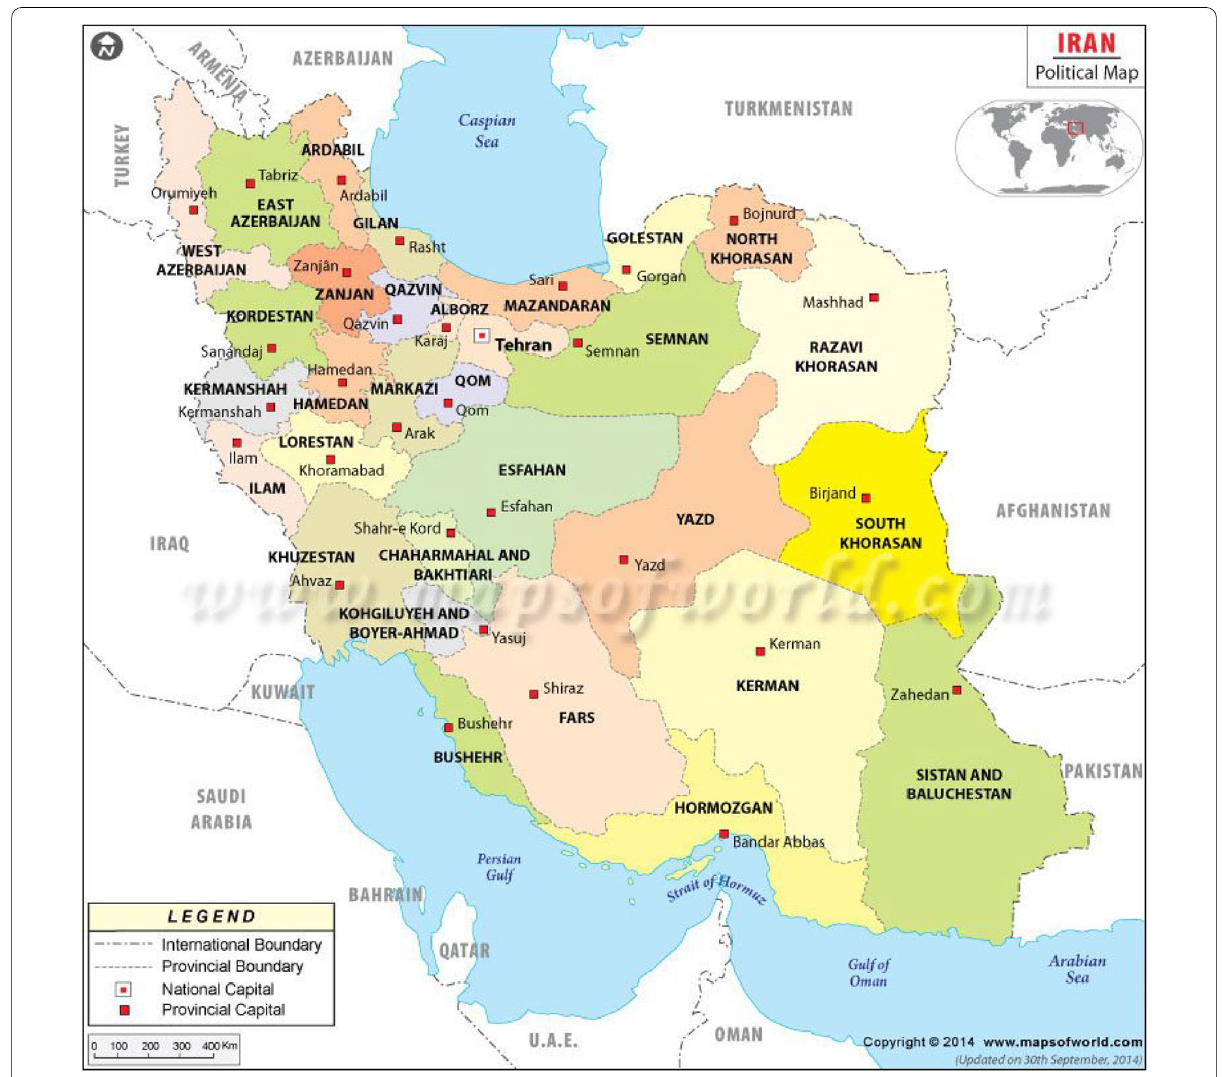
Fig. 1 The map shows the positions of the cities under study in Iran Source: https:// www. mapso fworld. com/ iran/ iran- polit ical- map. html. The following table shows the names of cities with their area and